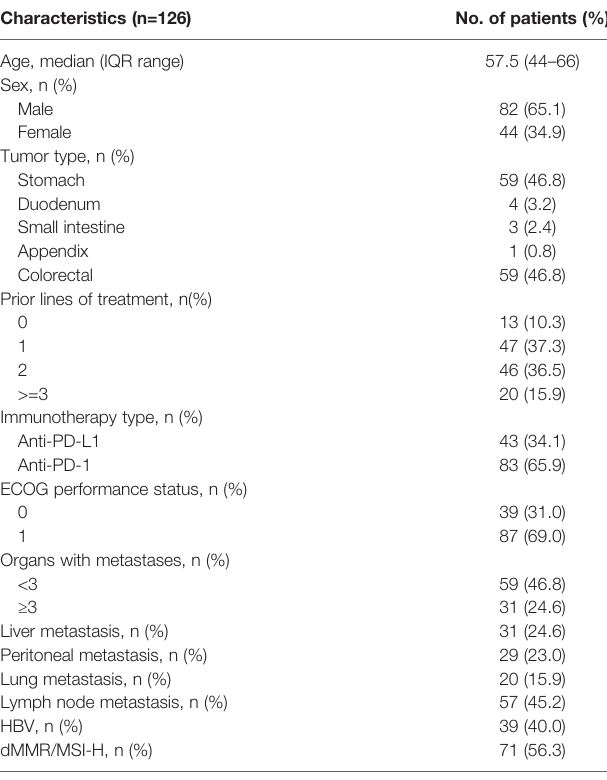
TABLE 2 | Baseline